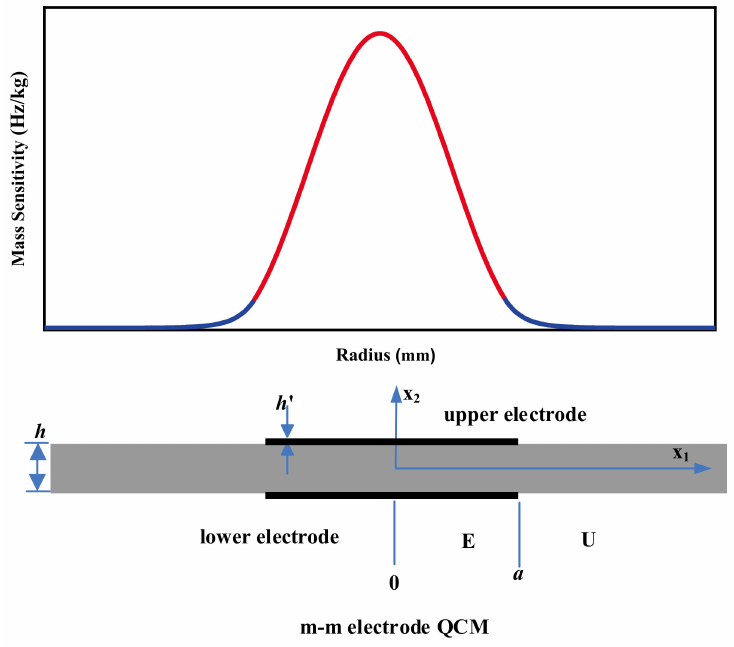
Figure 2. Schematic diagram of the structure and mass sensitivity distribution of the m-m electrode QCM [31]. Here a is the radius of the circular metal electrode. h and h (cid:48) are the thickness of the quartz wafer and the metal electrode,